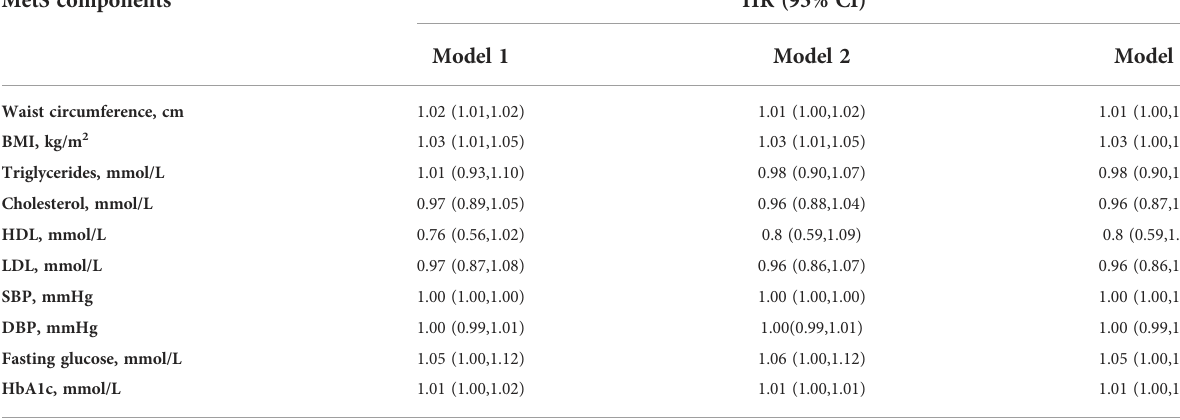
TABLE 4 Risk of bladder cancer in the UK biobank cohort in relation to individual MetS